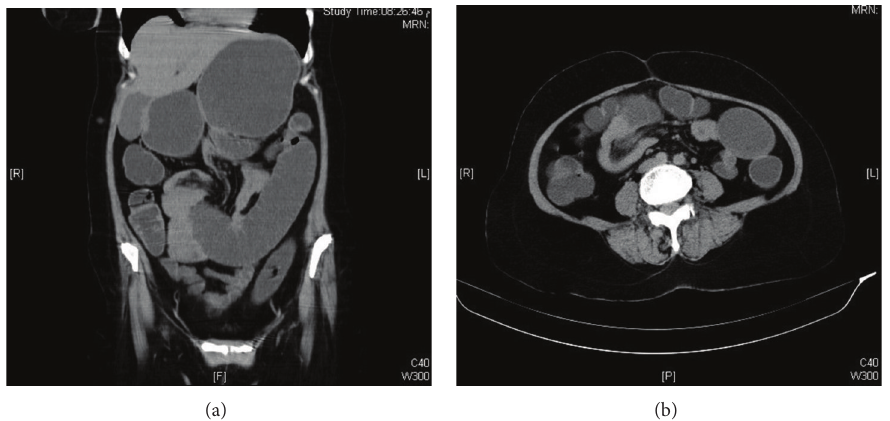
Figure 2: Computed tomography (CT) abdomen without contrast showing (a) coronal view: distended stomach, proximal small bowel loops extending down to midabdominal level where there was abrupt change in caliber of the bowel, and collapse of distal small bowel loops and (b) axial view: a soft tissue density lesion containing